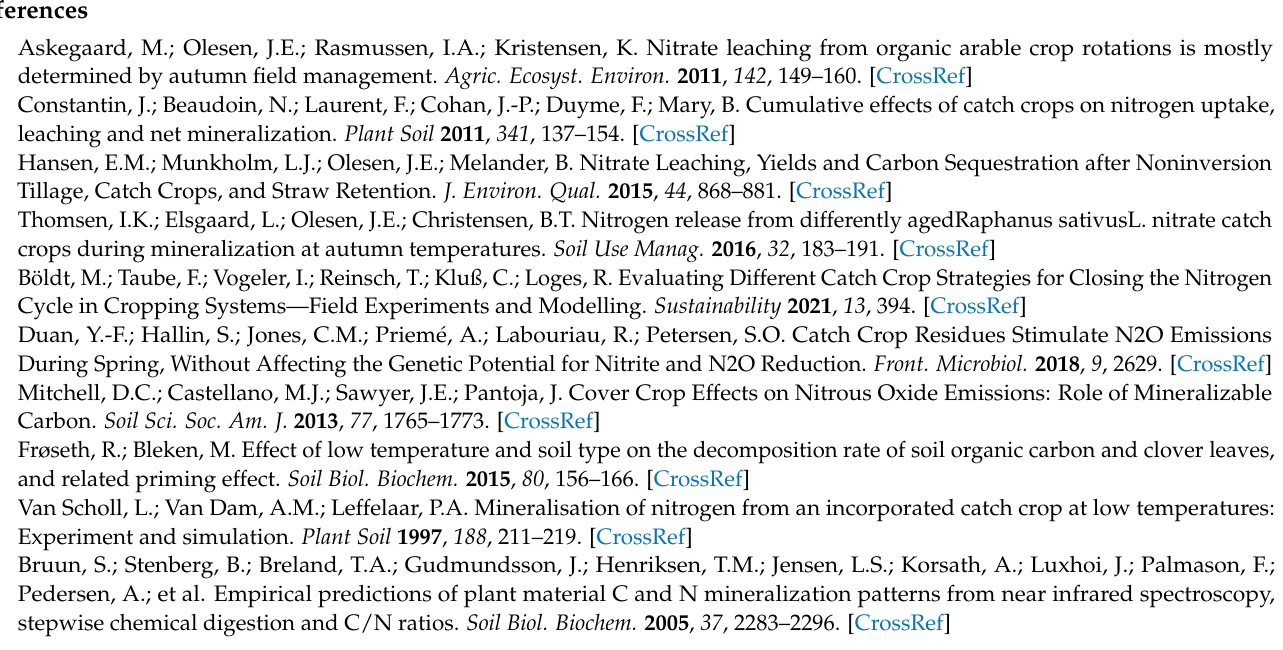
Figure A1. N net (mg-N) values fitted by nonlinear least-squares regression using a first-order kinetics model (FOK), an FOK model with an exponential lag term (ex), a Gompertz-type equation (Gom), and a Monod-type equation (Mon). The gray circles ( ○ ) represent the experimental objective data. All amounts are reported as total weight (in mg of N) per soil core (~250 mg DW).